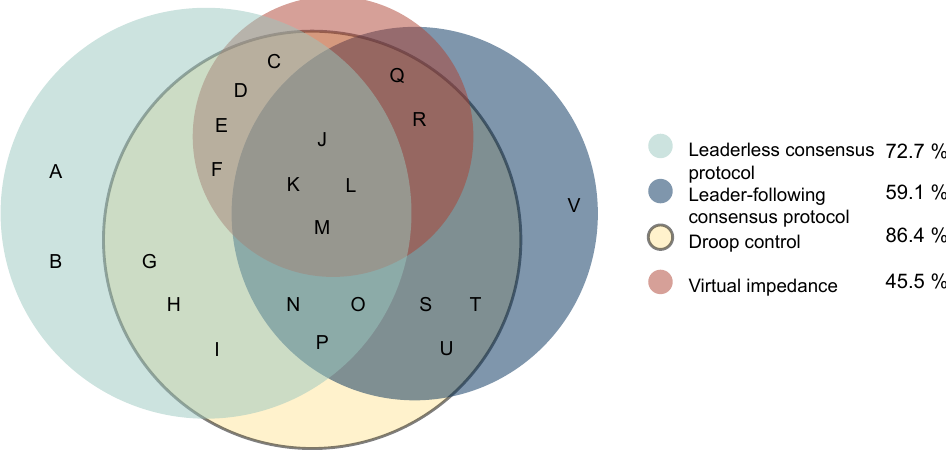
Figure 11. Sample of publications related to consensus protocol in control systems for microgrid control strategies and techniques combined. Legend: A—Duan, 2019 [78], B—Pham, 2021 [111],